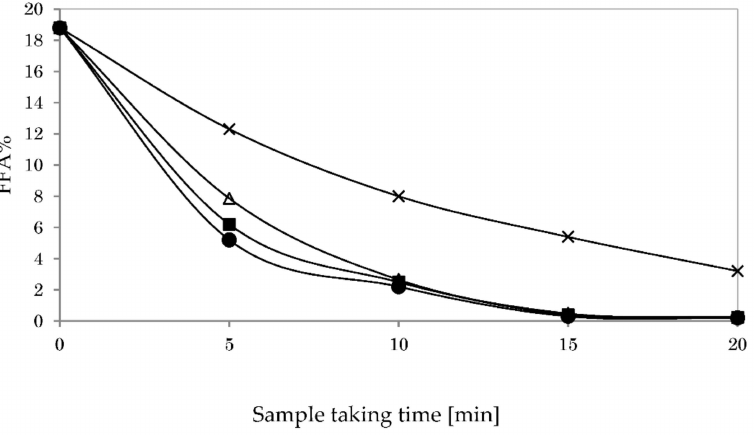
Figure 17. Impact of the amount of the Co-Solvent on glycerolysis reaction ( × : 10:1, ∆ : 8:1, (cid:4) : 6:1, • : 4:1), (Temperature: 200 ◦ C, Time: 30 min, Stirring speed: 350 rpm, Catalyst: 1 wt.% KOH, Oil-to-glycerol molar ratio: 1:4, Co-solvent: